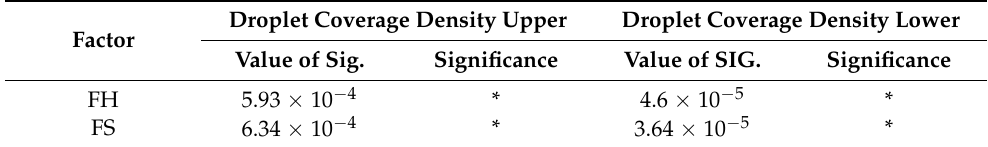
Table 6. Variance analysis of droplet coverage density. Factor